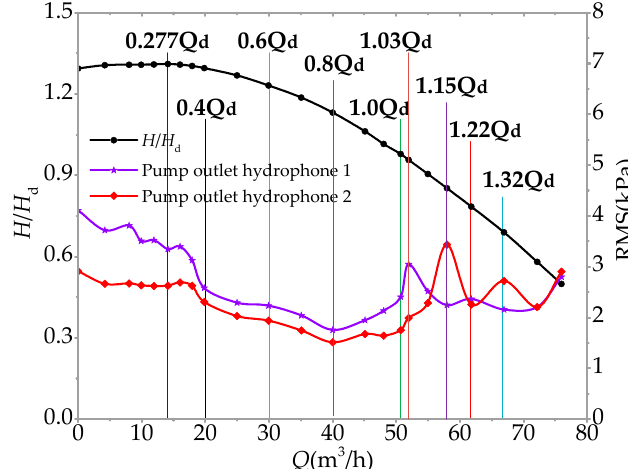
Figure 13. RMS of the pump outlet acoustic pressure under different flow rates.